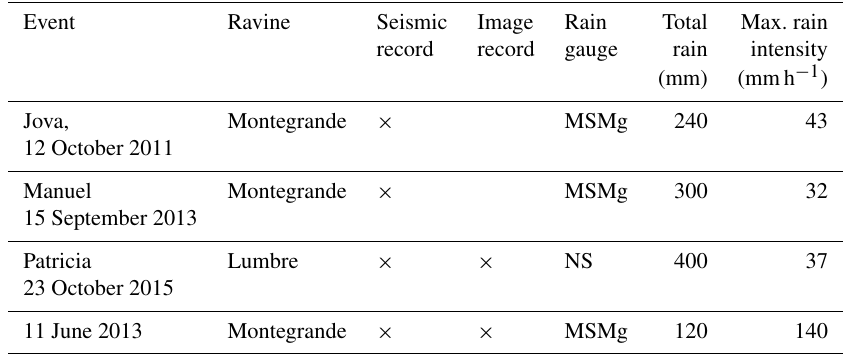
Table 1. Data collected for the events studied in this paper. Event Ravine Seismic Image Rain Total Max. rain record record gauge rain intensity (mm) (mmh − 1 ) Jova, Montegrande × MSMg 240 43 Montegrande MSMg × × Montegrande × × MSMg